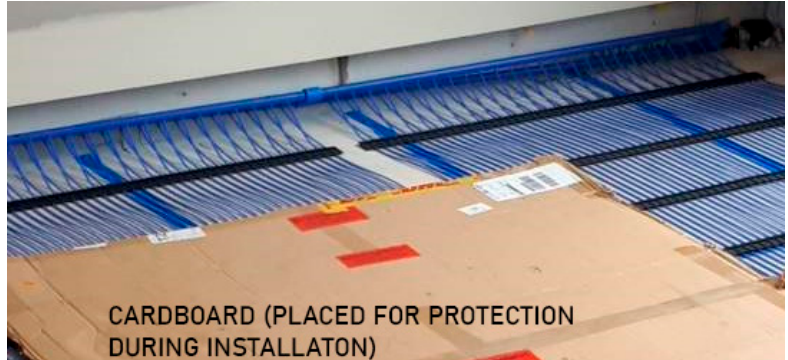
Figure 9. Capillary tube installation on a floor. Source: KPW Solutions.